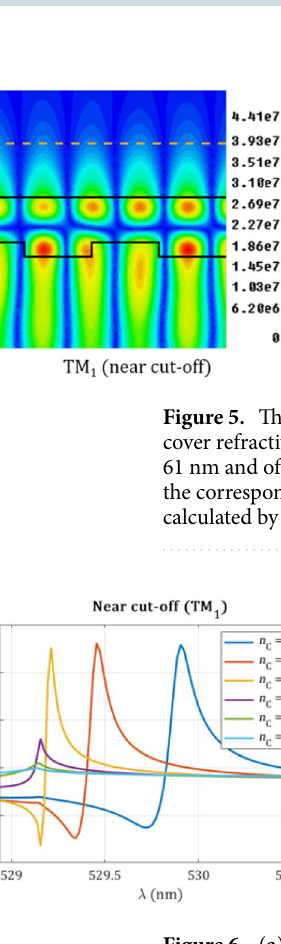
Figure 6. ( a ) The d c cut-off curves and the resonance wavelengths for the TM 0 and TM 1 modes with an incidence angle of 26° for decreasing n C from the analytical calculations. ( b , c ) The reflection spectra of the TM